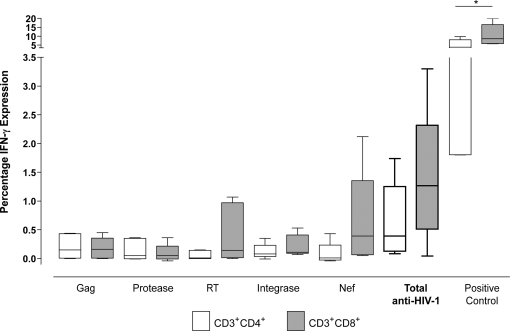
IFN-γ responses are derived from both CD4+
and CD8+ T cells. CD4+ (open boxes) and CD8+ (shaded boxes) T cell IFN-γ responses towards HIV-1 derived peptide pools Gag, Protease, RT, Integrase and Nef, plus the cumulative anti-HIV-1 response and a SEB positive control. No significant difference was observed between the two T cell subsets (n = 5).